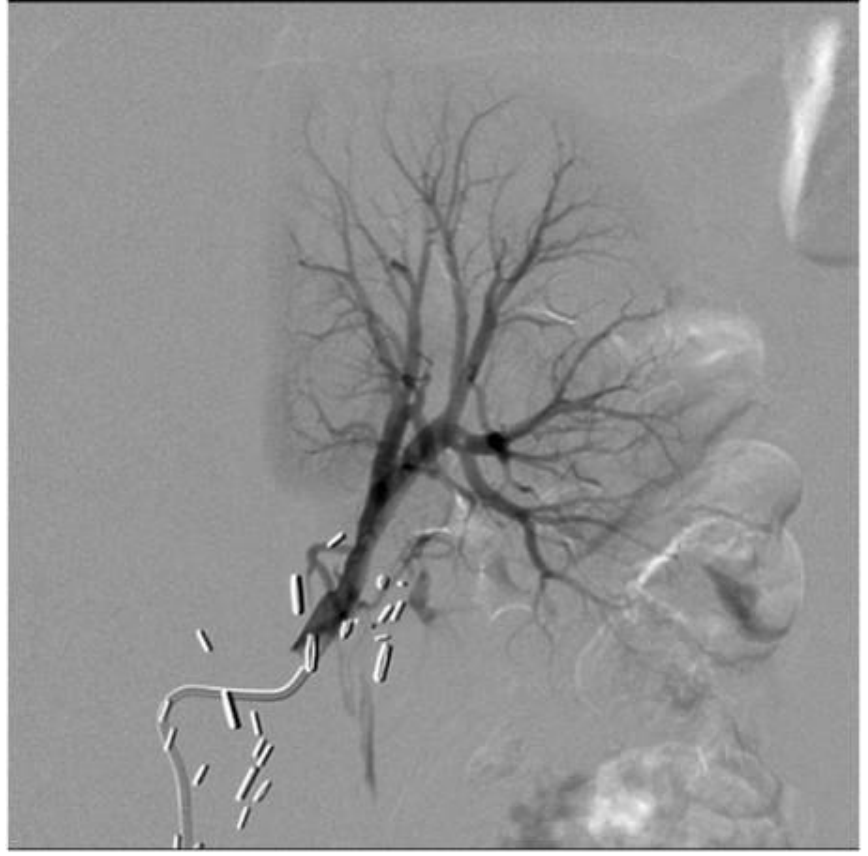
FIGURE 2 . Renal arteriogram showing delayed filling in the lower pole of the